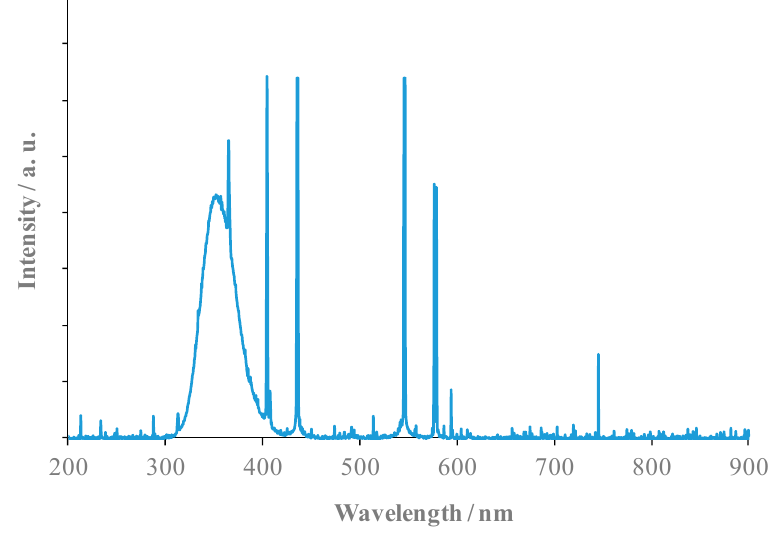
Figure 12. The emission spectrum of the UV-Vis solar lamp (Philips). The photocatalytic tests were performed for the synthesized samples and two commer- cial ones, “nanorutile” produced by Sachtleben (Krefeld, Germany) and nanocrystalline anatase KRONOClean 7050, produced by Kronos International Ltd. (Germany).